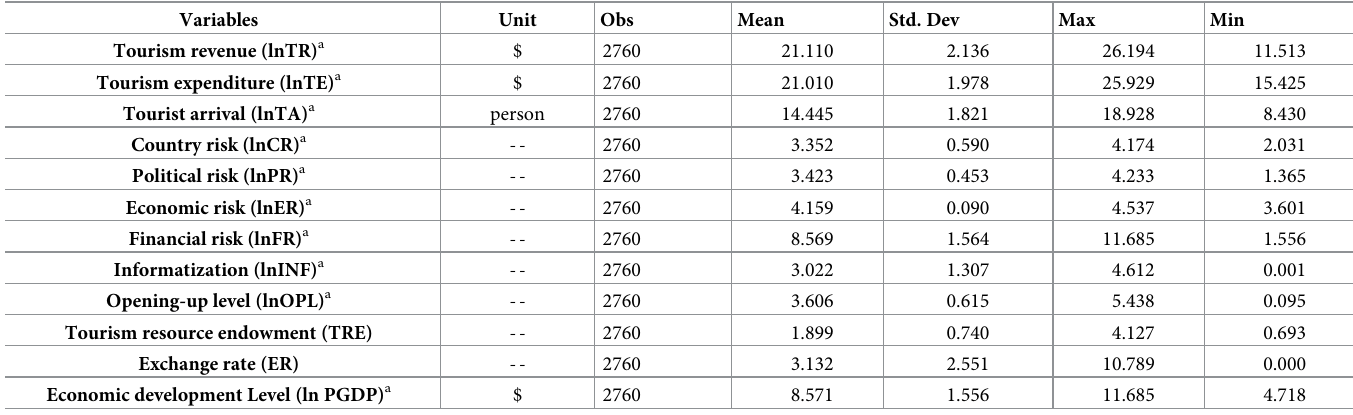
Table 2. Descriptive statistical results of the